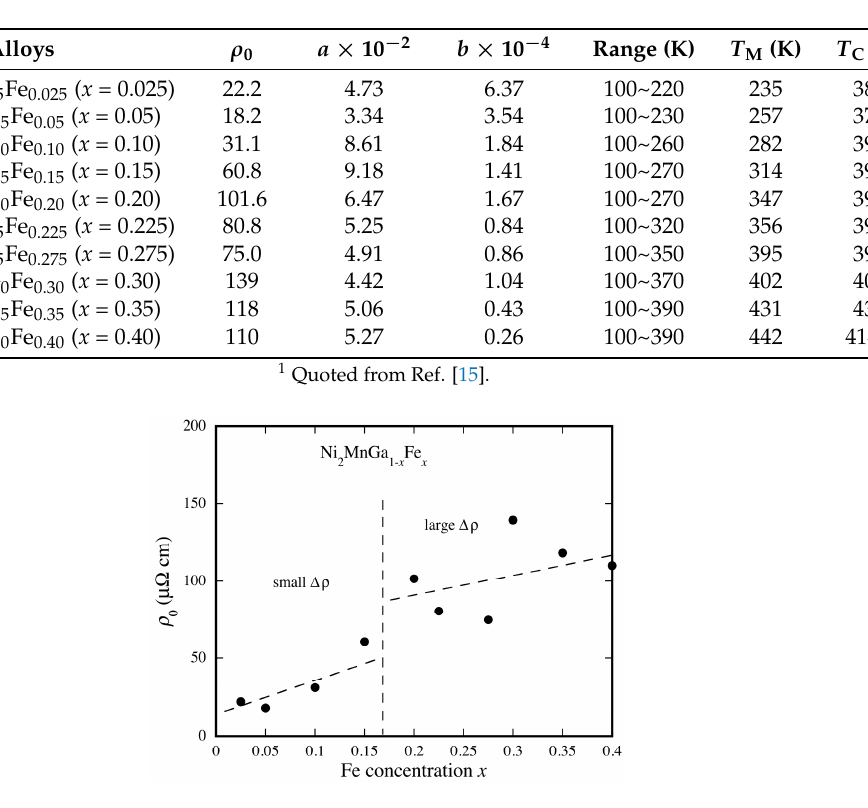
Figure 4. The concentration dependence of the residual electrical resistivity ρ 0 for Ni 2 MnGa 1– x Fe x . The black dots are ρ 0 obtained from the analyzed data as shown in Table 1, with dashed lines being guides to the eye. The vertical dotted lines distinguish the electric properties of Ni 2 MnGa 1– x Fe x to two regions.